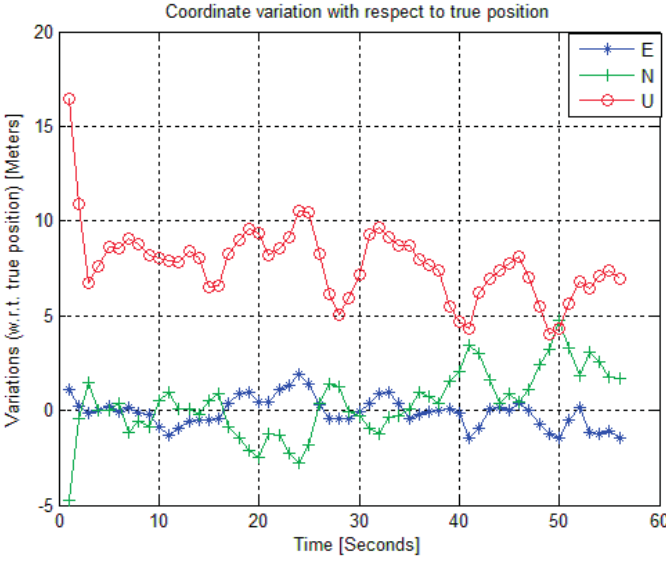
Figure 10. Position error variations with respect to true position in ENU frame.